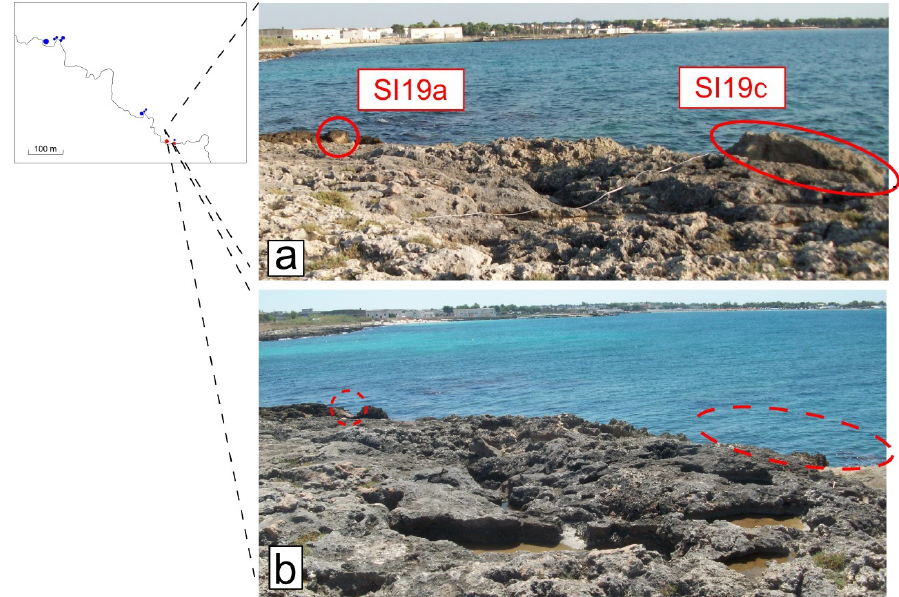
Figure A2. Comparison between pre- and post-storm event states; ( a ) photo taken before the storm with Boulders a and c; ( b ) photo taken after the storm; the lack of boulders is highlighted by the dashed